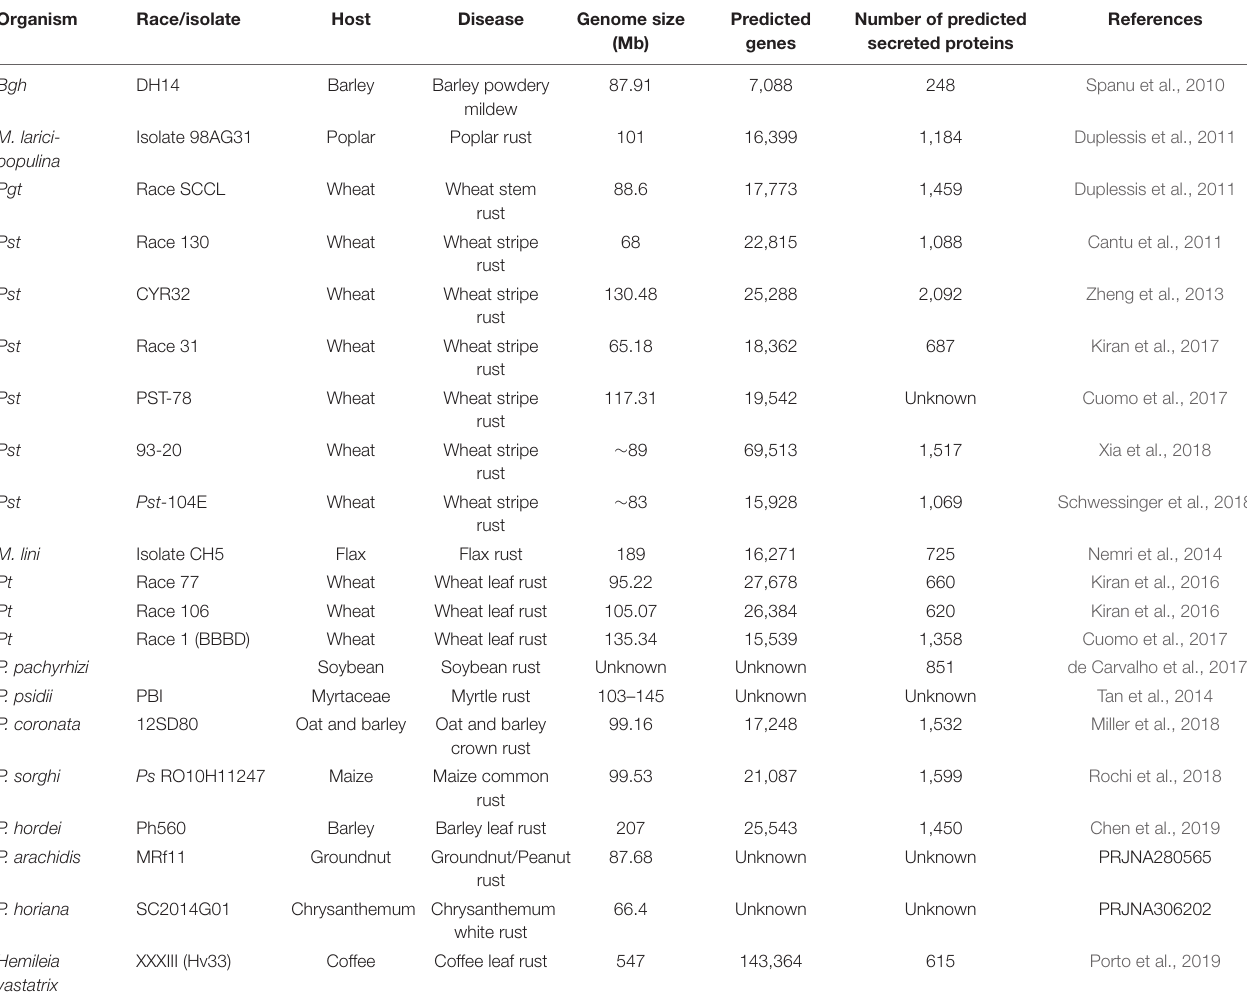
TABLE 3 | Genomic sequencing and features of biotrophic plant fungal